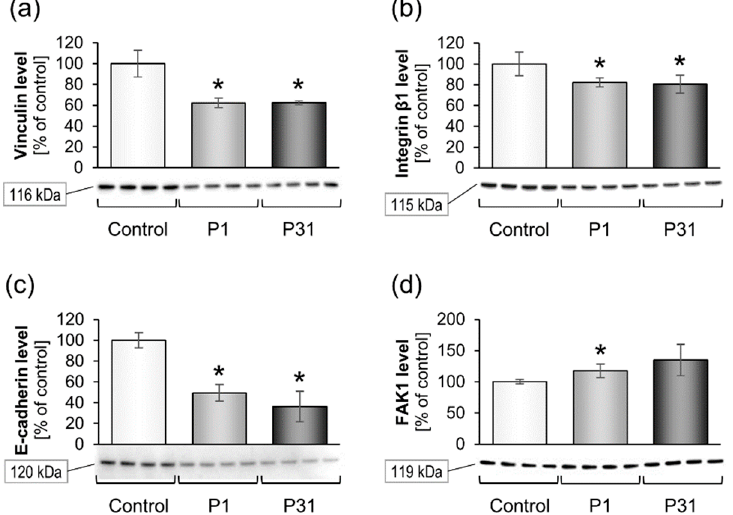
Figure 6. Influence of short-term microgravity on the protein accumulation of focal adhesion complex components. The data is given as mean ± standard deviation. * p < 0.05 vs. Control.